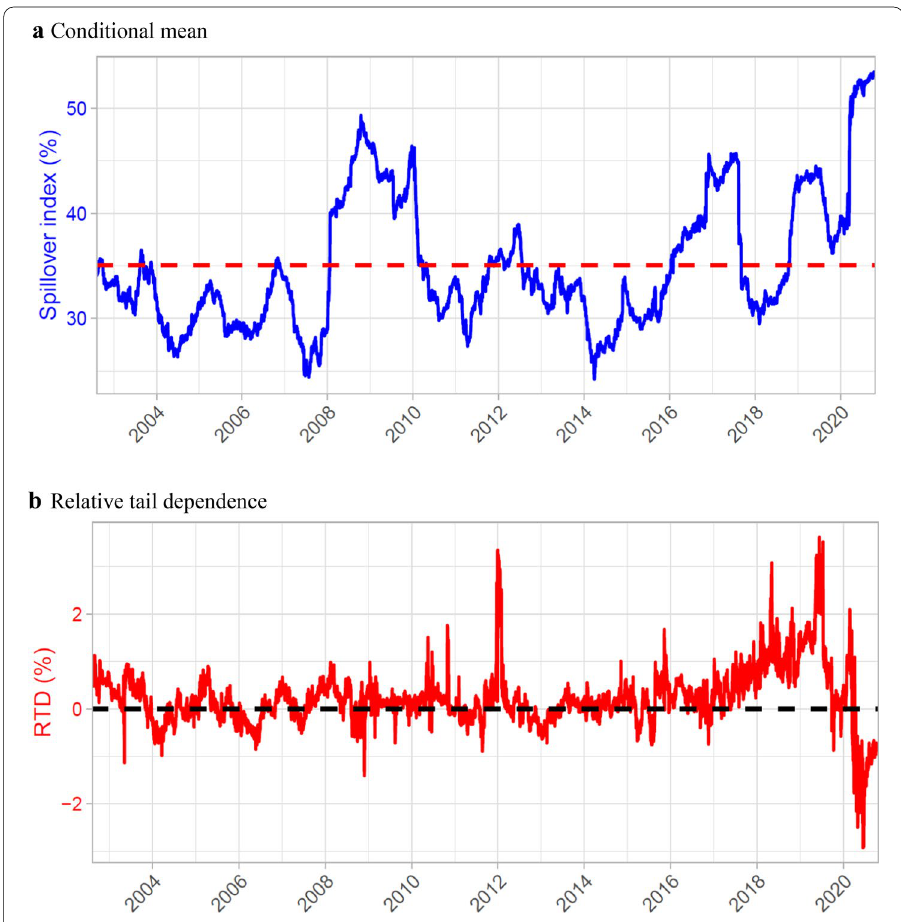
Fig. 7 Time-varying spillover and relative tail dependence. a Conditional mean, b relative tail dependence. Notes: This figure shows the value of the spillover index defined in (6) evaluated at the mean (shown as the blue line in panel ( a )) and the difference between the spillover index at the 95th and 5th conditional quantiles (shown as the red line in panel ( b )). The results are obtained from rolling regressions with a window length of 200 trading days, lag order of 1 day and forecast time horizon of 12 days. The dates shown correspond to the last day of each rolling